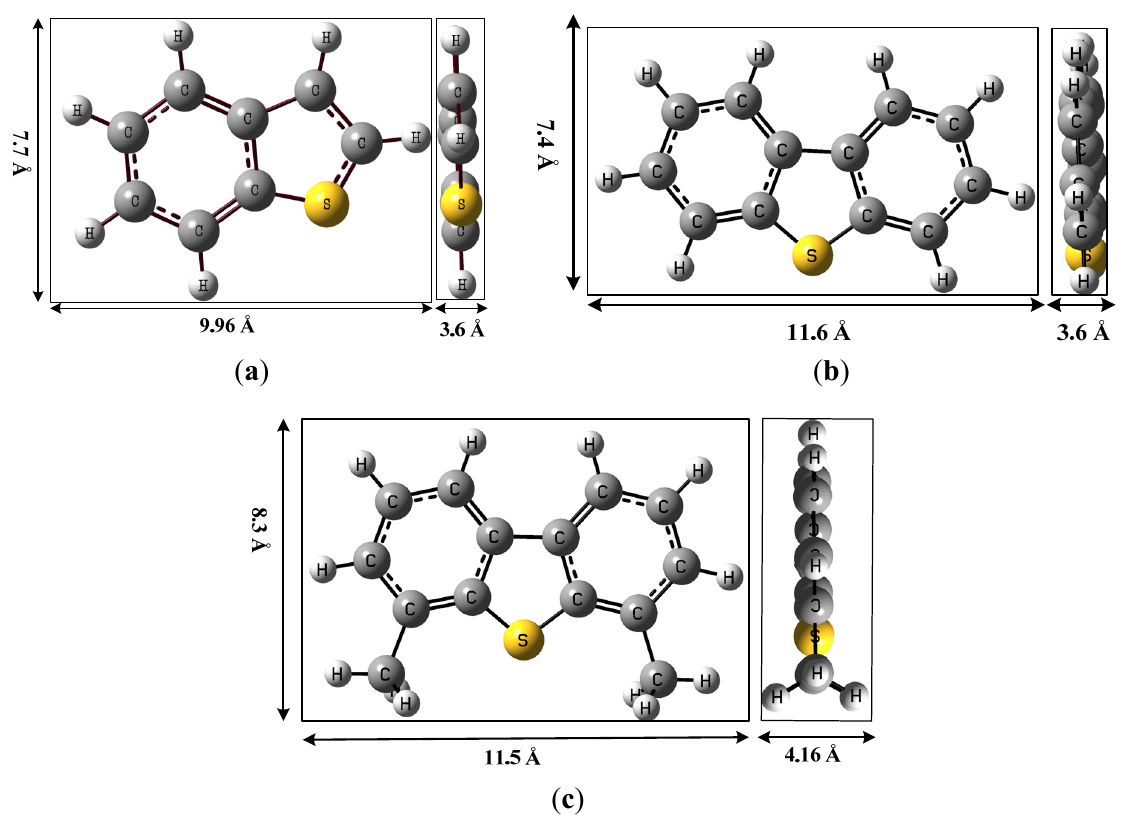
Figure 6. Molecular dimensions and structures of ( a ) BT; ( b ) DBT; and ( c ) 4,6-DMBT calculated from the DFT model in the Gaussian 98